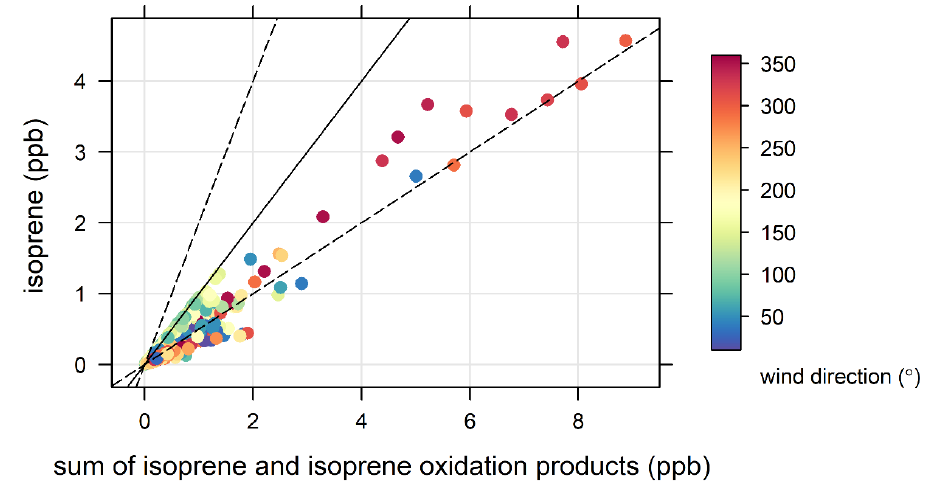
Figure A4. As in Figure 5, but including data from the hot days.